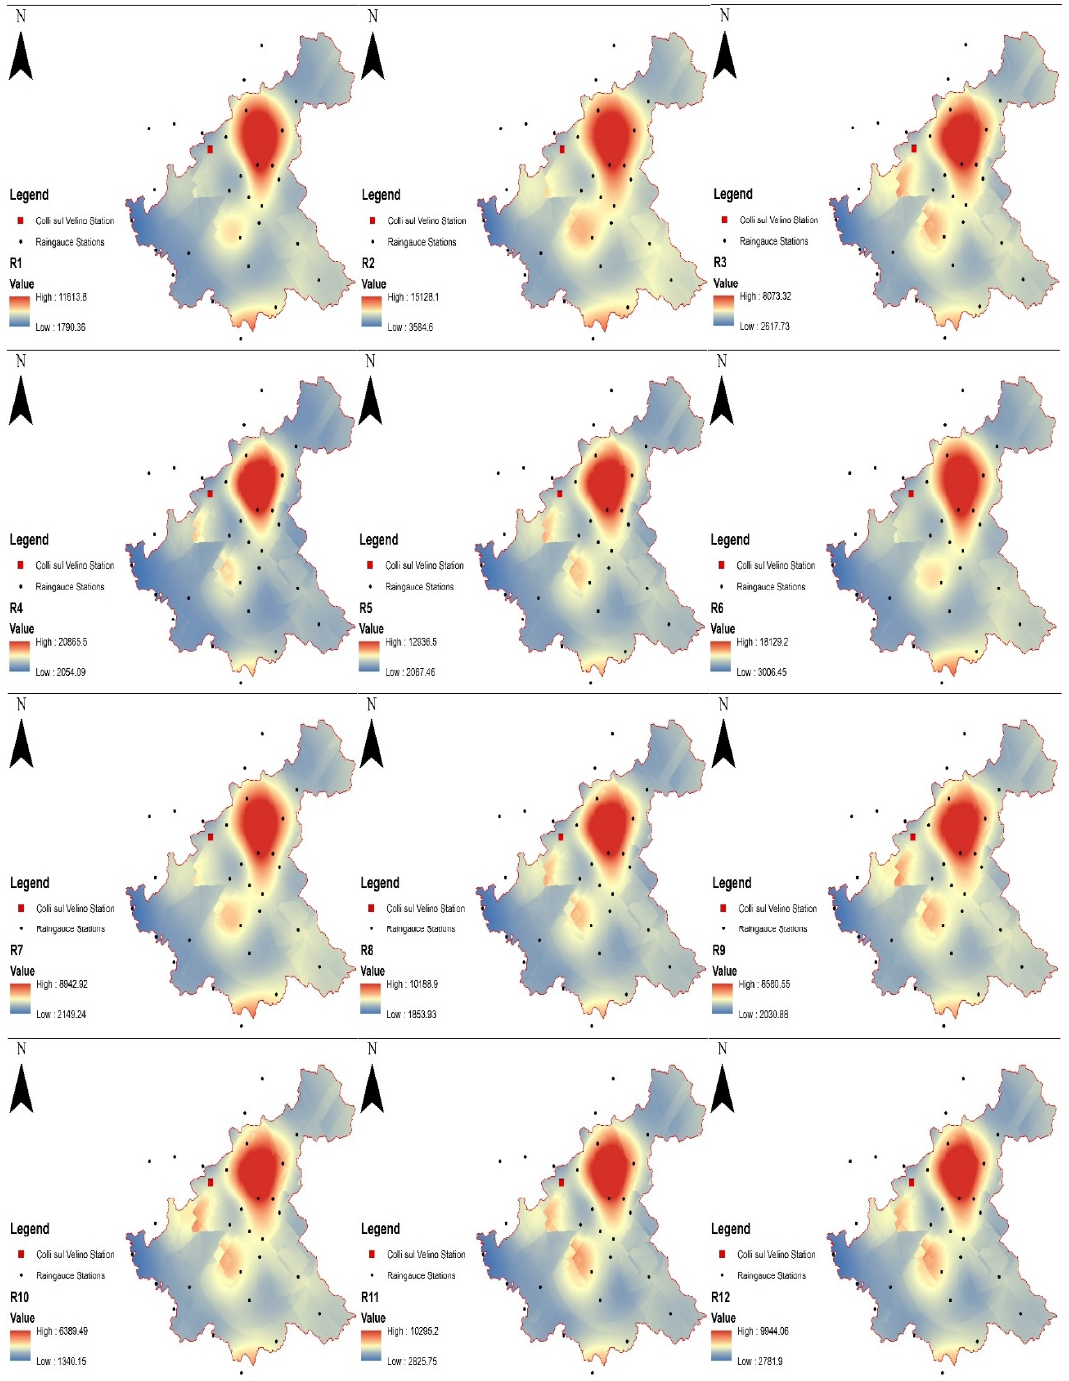
Figure 5. Rainfall erosivity maps created using the 12 equations. All the values are expressed in MJ * mm * ha − 1 * h − 1 * year − 1.